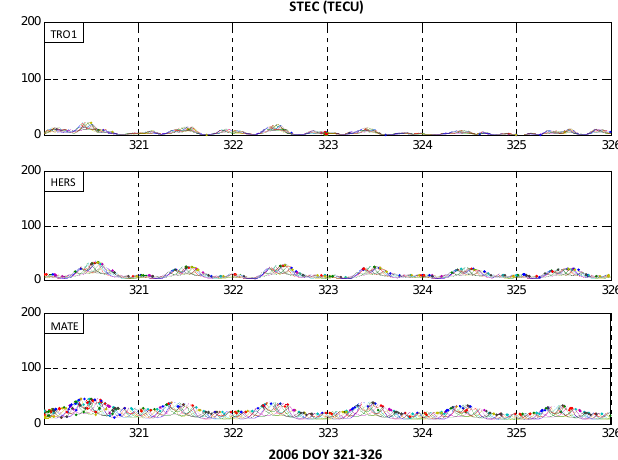
Fig. 11. STEC (TECU) for the three observation stations on 321– 326 in 2006.